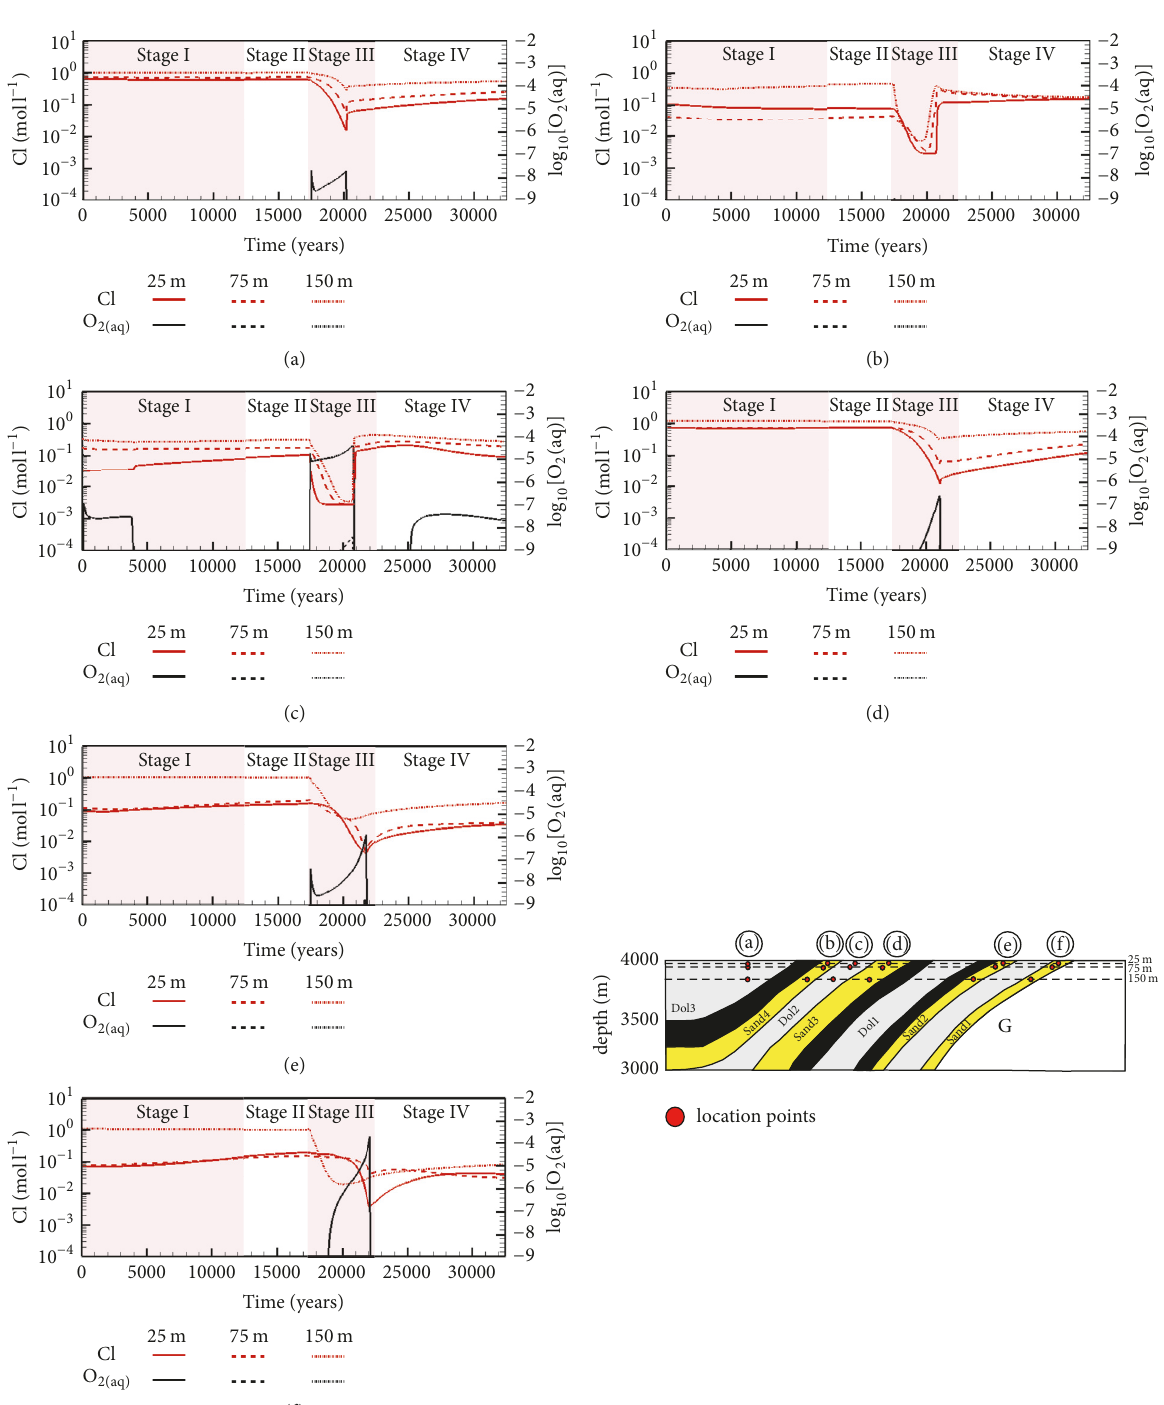
limited to depths of less than 200 m at concentrations